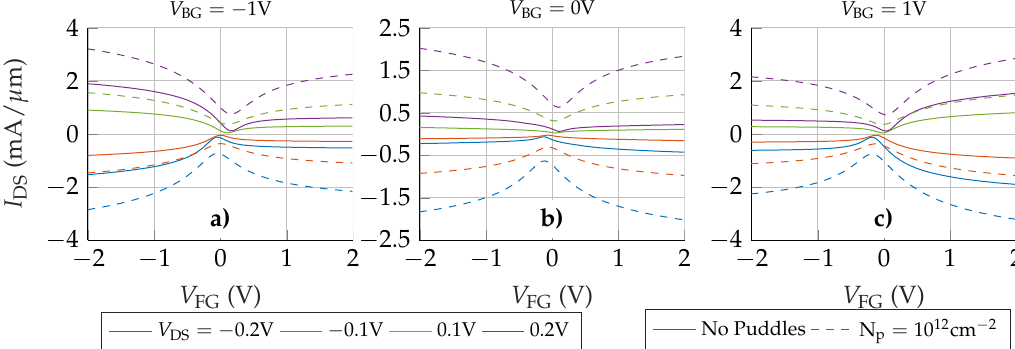
Figure 6. I DS − V FG characteristics of the complete structure when three different back gate potentials are used ( − 1 V ( a ), 0 V ( b ) and 1 V ( c )). Solid lines correspond to the device without puddles and dashed lines to the device with N p = 10 12 cm − 2